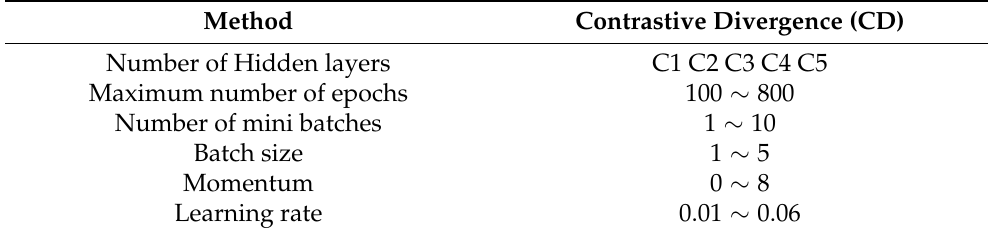
Table 3. Parameters used for the Contrastive Divergence (CD) DBN